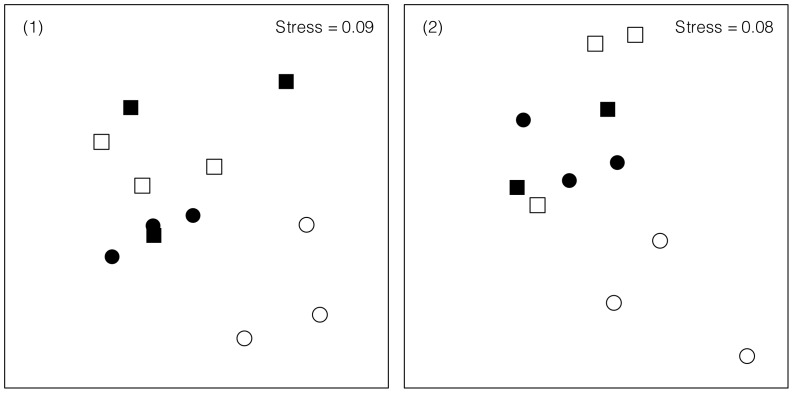
Effects of composition of experimental landscapes on benthic assemblages. nMDS ordination of Bray-Curtis distances of assemblages colonizing each experimental landscape with different composition using densities of species from n = 3 replicate patches in each site (1 or 2). Symbols indicate different types of landscapes: Sparse (□), Dense (○), Sharp (•) and Gradual (▪). Pair-wise tests of significance of differences between assemblages are in Table 3d.